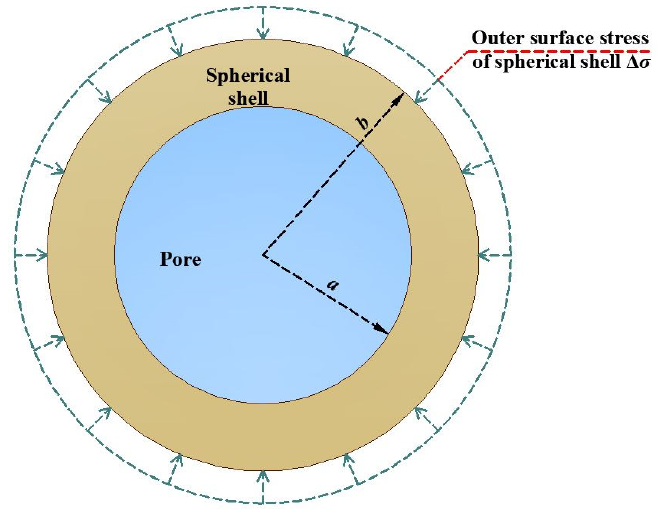
Figure 2. Schematic of the spherical shell section of the medium element.